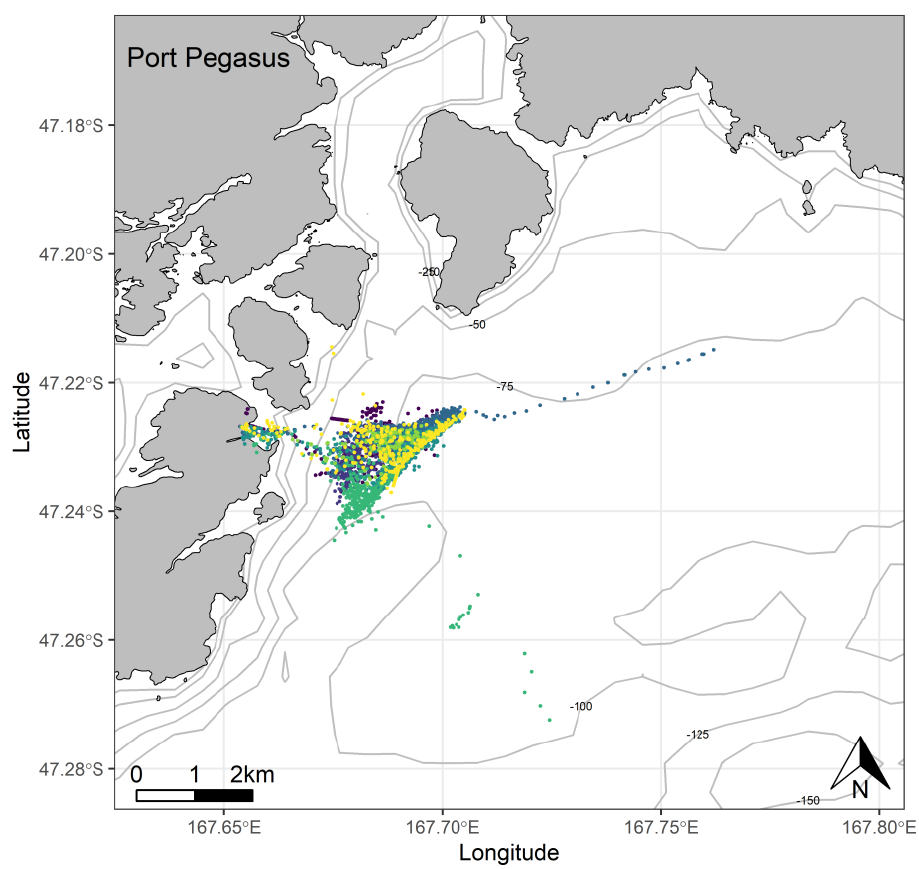
Figure 4. At-sea location fixes (travelling and foraging) of adult breeding yellow-eyed penguins during the chick-guard stage of breeding from Port Pegasus, Stewart Island ( n = 7), 2020/21.